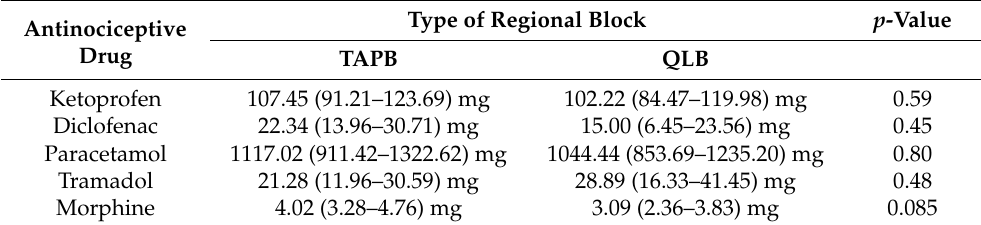
Table 4. Mean analgesic drug consumption during the first 24 h after the surgery.